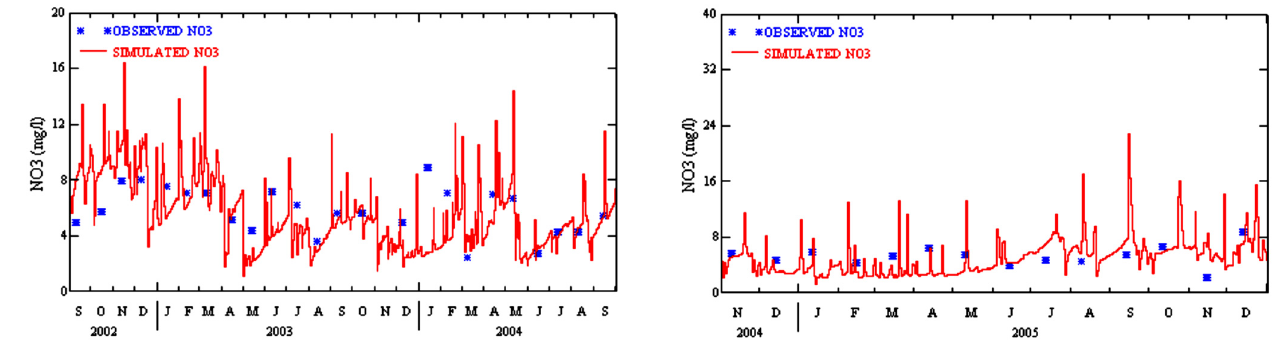
Figure 3. Total nitrates calibration and validation.